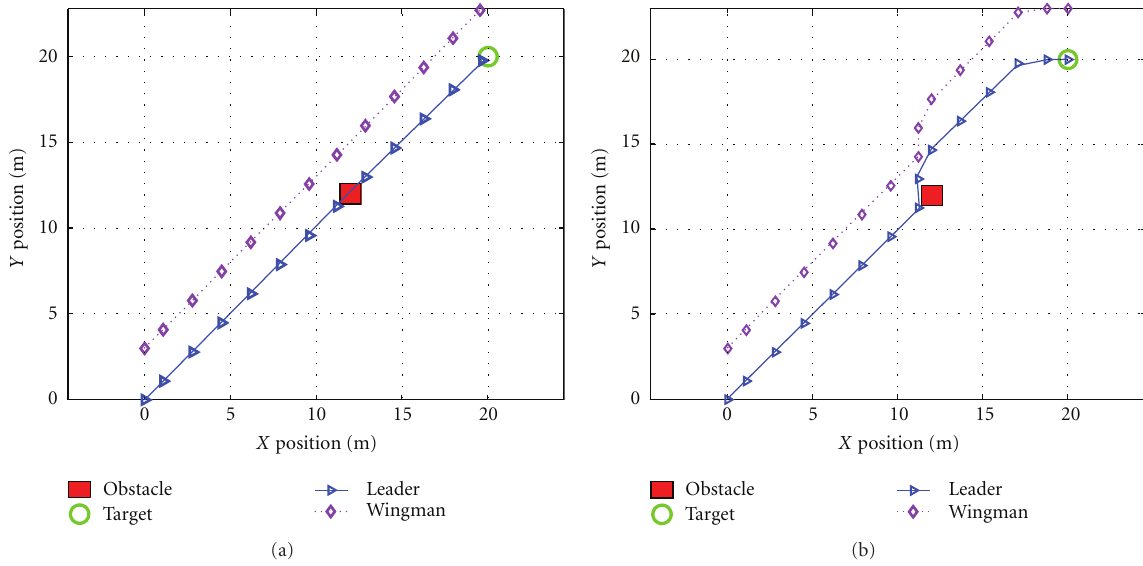
Figure 10: Small-obstacle-collision free formation flight. (a) Formation without position constraint. (b) Formation with position